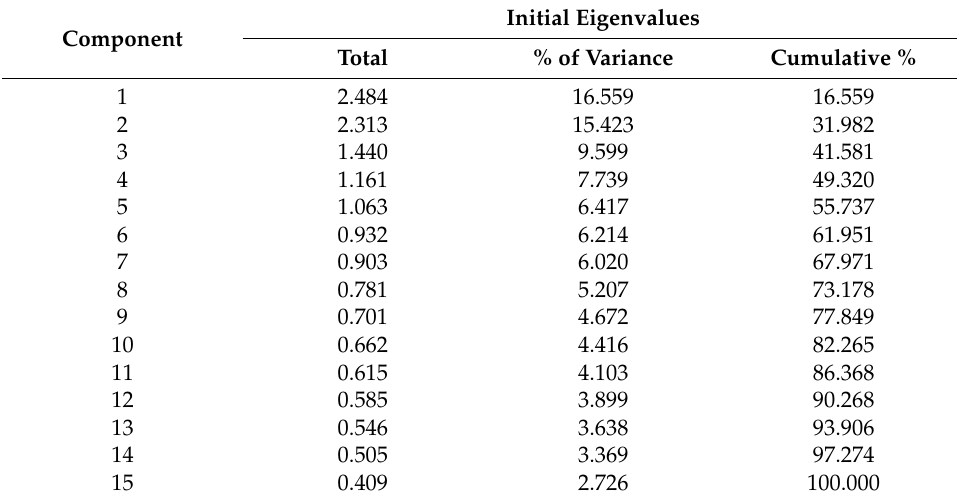
Table 3. Principal component analysis for the 15 items of the New Environmental Paradigm Scale (NEP).